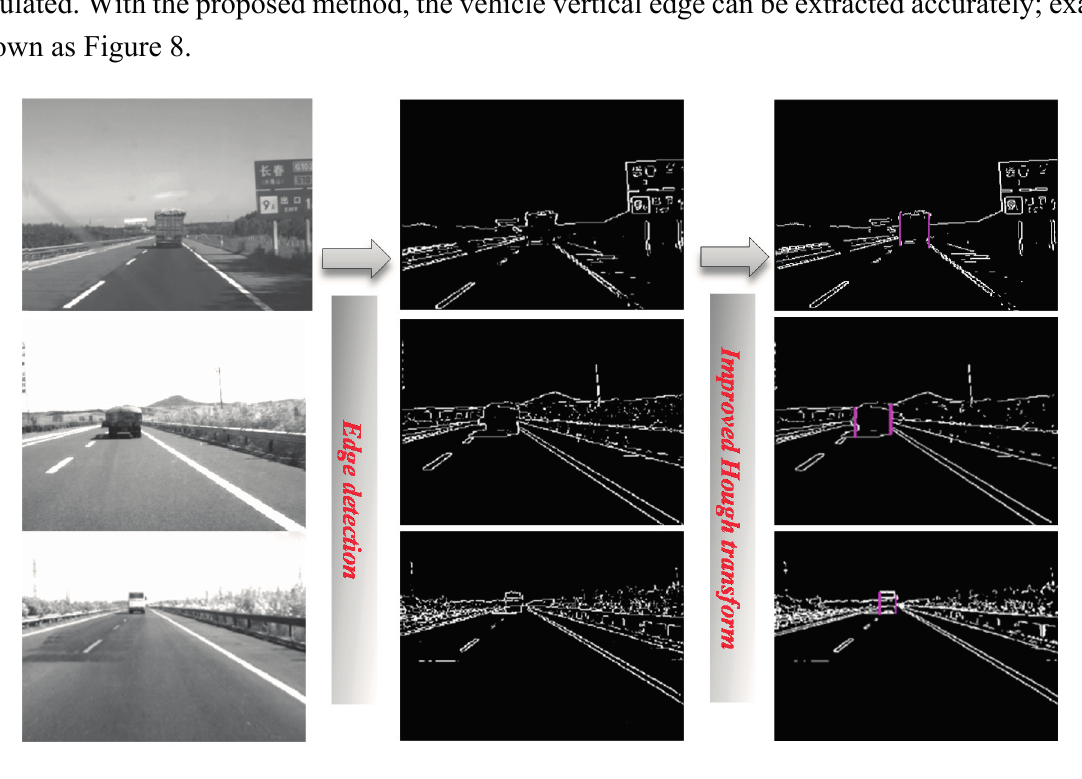
Figure 8. Examples for vertical edges